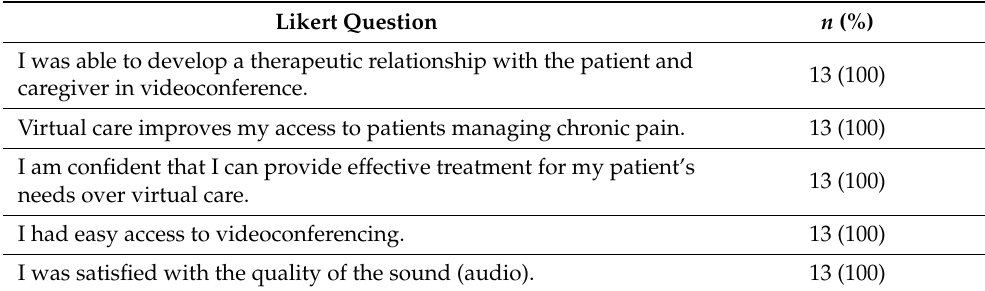
Table 3. Satisfaction survey responses: All healthcare professionals in agreement.